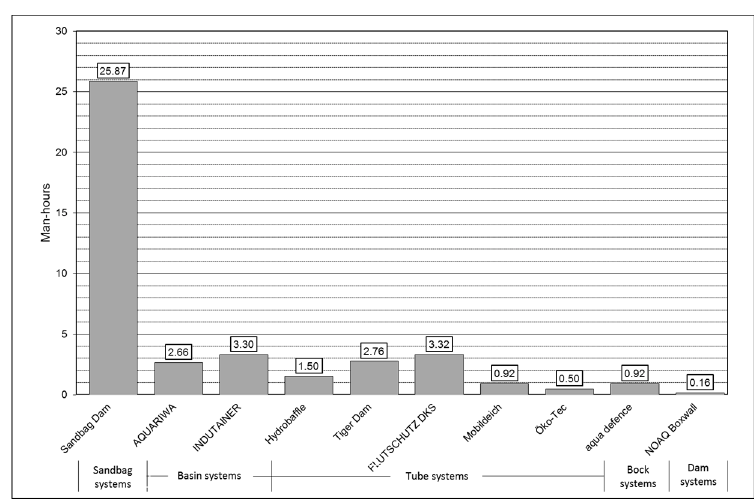
Figure 10. Time needed to install a 15 m location-independent mobile flood protection system expressed in man-hours.